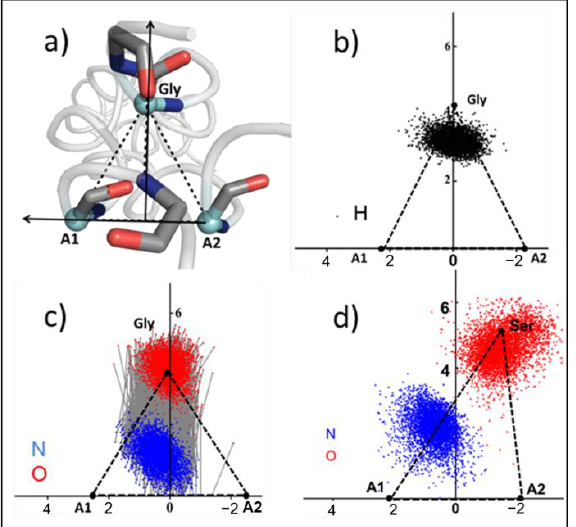
Figure 5. The distributions of nitrogen, oxygen and hydrogen atoms in H-bonds. ( a ) Top view of the C α triangle. ( b ) The distribution of hydrogen atoms in a stable triangle. ( c ) The distribution of nitrogen and oxygen atoms in a stable H-bond. ( d ) The distribution of nitrogen and oxygen atoms in a broken H-bond in a17S. Hydrogen atoms are shown in black, nitrogen atoms are shown in blue, oxygen atoms are shown in red.